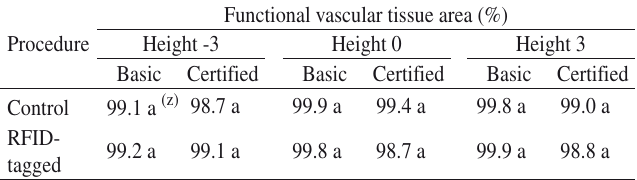
Table 4 - Effects of implantation procedures on functional vascular tis- sue area (%), measured at three heights, in RFID-tagged basic (four-year-old) or certified (one-year-old)